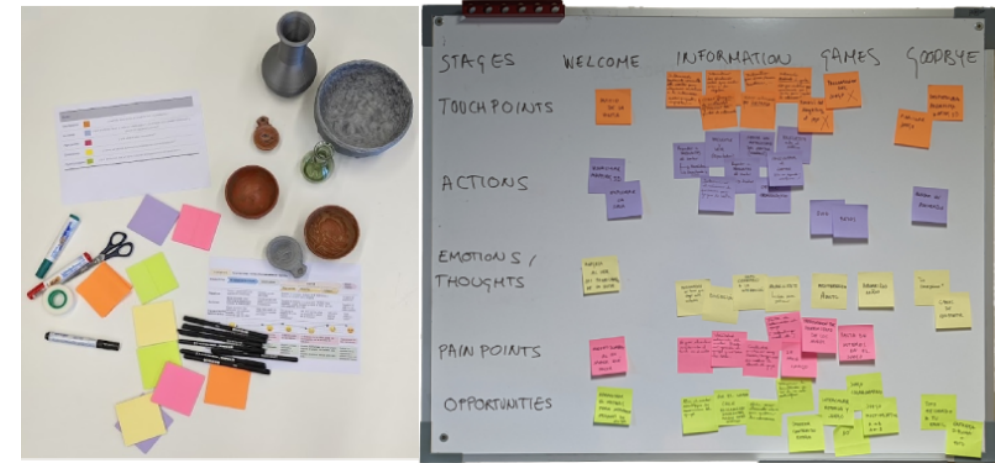
Figure 4. The material used during the second brainstorming session for designing an empathetic and interactive cultural heritage immersive experience.